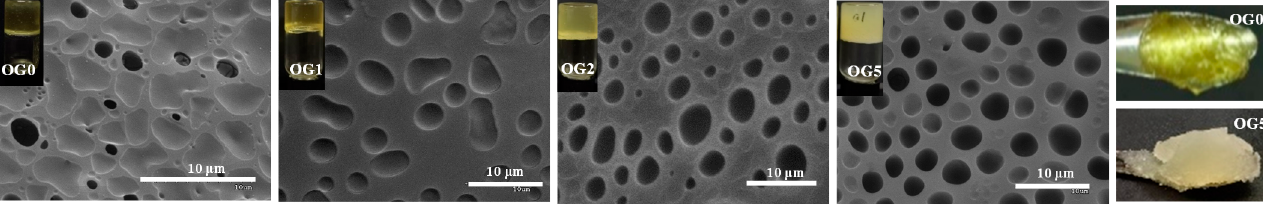
Figure 1. Macro morphology and Microstructures of EC oleogels with different content of GMS.